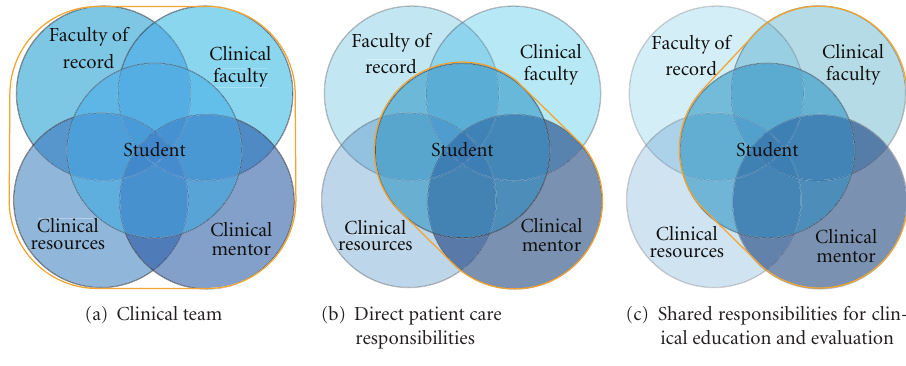
Figure 2: Clinical